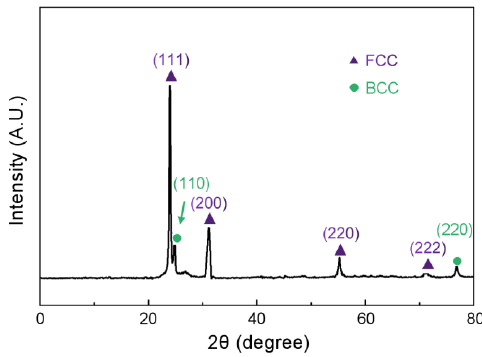
Figure 1. XRD pattern of as-cast Co 39.2 Ni 39.2 Al 21.6 EMEA. The side peak around 25 ° indicated by the green arrow is indexed as the (110) plane of BCC phase.